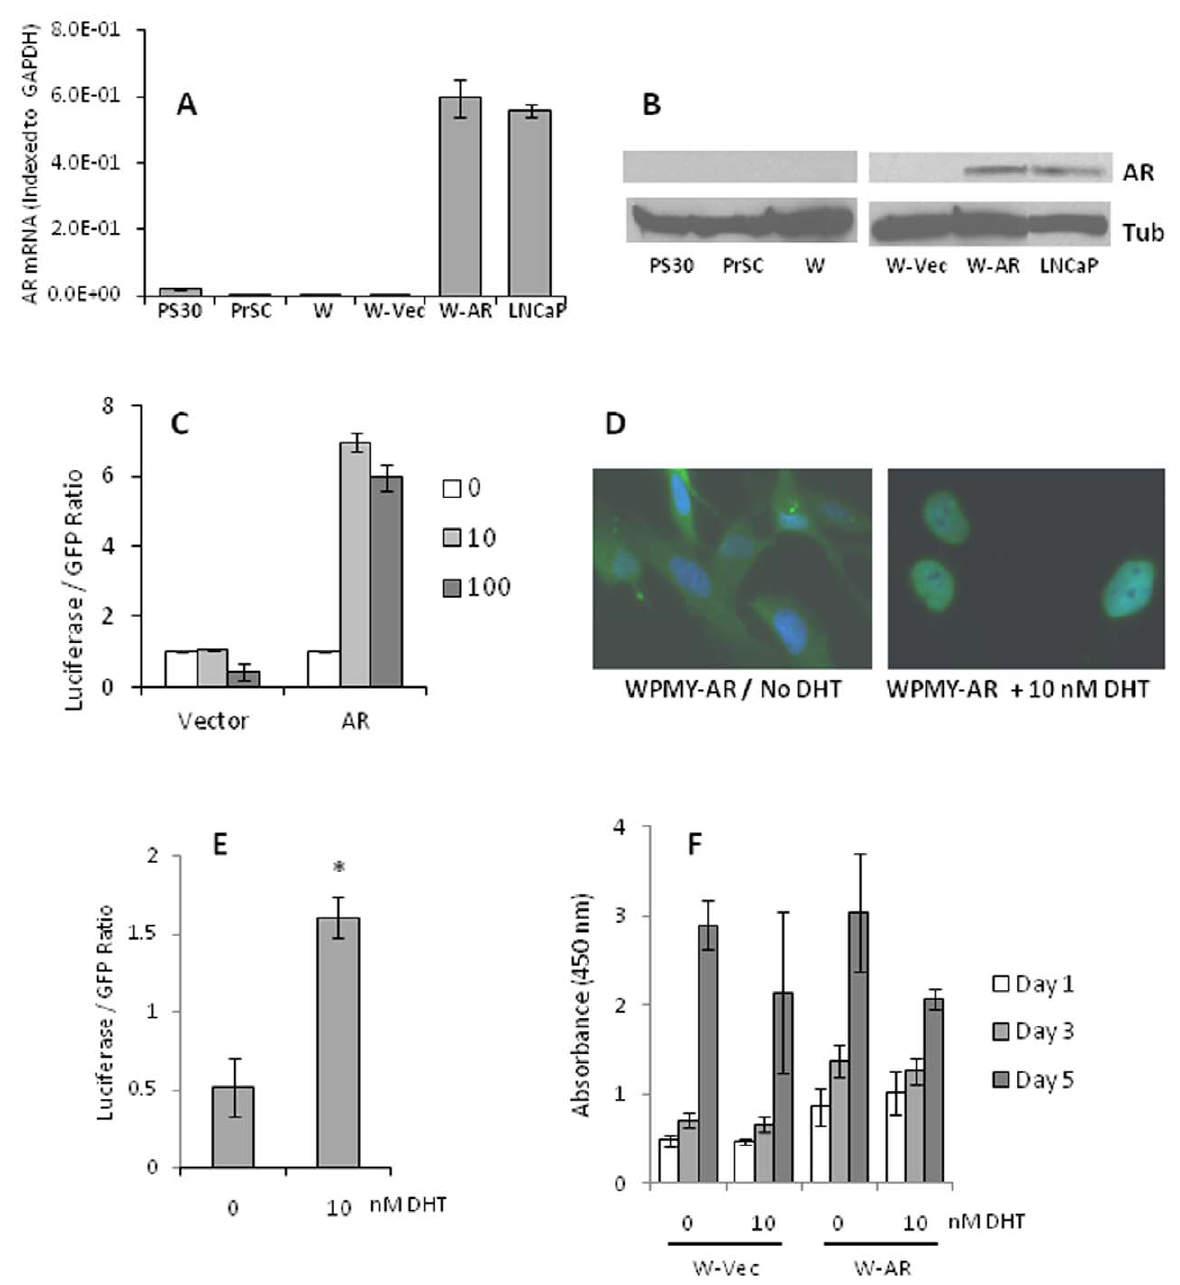
Figure 1. Androgen receptor expression and activity in prostate stromal cell lines. (A) AR mRNA levels in PS30, primary prostate stromal (PrSC), WPMY-1 (W), WPMY-Vec (W-Vec), WPMY-AR (W-AR) or LNCaP cells detected by real-time qPCR of RNAs extracted from the cells. Expression levels are indexed to the expression of GAPDH in each cell line. (B) AR protein (upper lanes) in PS30, PrSC, W, W-Vec, W-AR or LNCaP cells detected by Western blot. The blot was re-probed for GAPDH protein (lower lanes) as a control. (C) Luciferase reporter expression in WPMY-1 cells co-transfected with the ARE-luc reporter vector and a control (empty) vector (Vector) or the pLenti6.2-hAR vector (AR). Luciferase levels are normalized for GFP fluorescence in the same extract as the transfection control marker. (D) Immunofluorescent staining for AR in W-AR cells grown for 72 hrs in the absence (left) or presence (right) of 10 nM DHT. Cells were co-stained with DAPI to identify nuclei. (E) Luciferase activity in W-AR cells transfected with ARE-Luc and GFP in the absence or presence of 10 nM DHT. Luciferase activity was normalized by comparison to GFP levels in the same extract. (F). Growth of W-Vec or W-AR cells in the absence or presence of 10 nM DHT as measured by the WST-1 assay.